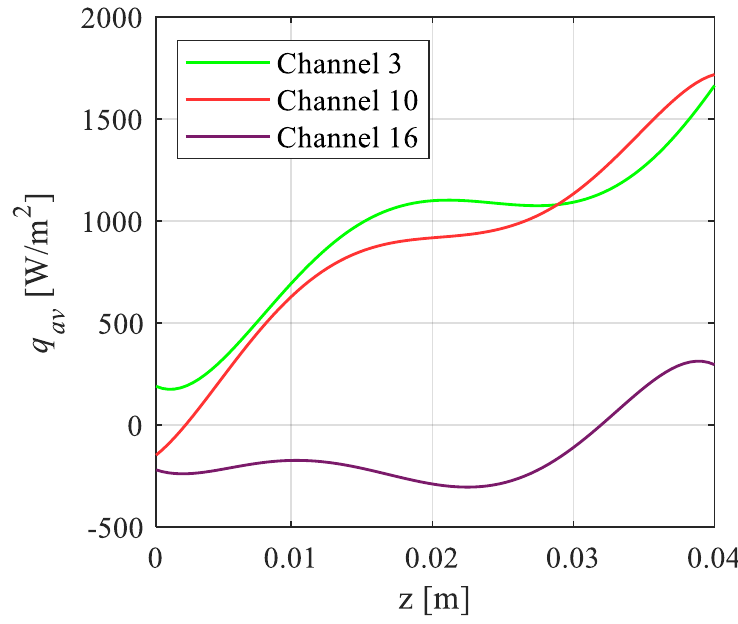
Figure 10. Space – time temperature distribution acquired by means of thermography ( a ) and